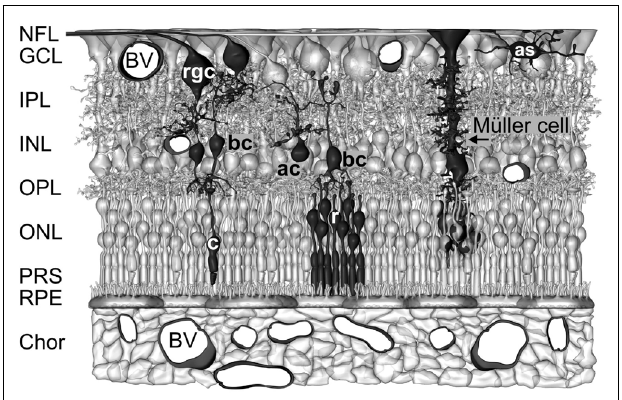
FIGURE 1 | Müller cells span the entire thickness of the neuroretina. Schematic drawing of the cellular constituents and basic neuronal circuits of a human retina.The inner retina contact the vitreal cavity ( top ) and contains the following retinal layers: nerve fiber layer (NFL), ganglion cell layer (GCL), inner plexiform layers (IPL), and inner nuclear layer (INL).The outer retina is directed to the outer surface of the eye and contains the following retinal layers: outer plexiform layer (OPL), outer nuclear layer (ONL), the subretinal space containing the photoreceptor segments (PRS), and the retinal pigment epithelium (RPE).The outer retina is supplied with oxygen and nutrients by the blood vessels (BV) in the choroid (Chor), while the inner retina is supplied by intraretinal vessels. Astrocytes (as) are localized in the NFL/GCL.The perikarya of Müller cells are localized in the INL. From the perikaryon, two stem processes of Müller cells extend toward both surfaces of the neuroretina.The funnel-shaped endfeet of Müller cells form (in association with a basement membrane) the inner surface of the retina. In the OPL and IPL, side branches which form perisynaptic membrane sheaths originate at the stem processes. In the ONL, the stem process of Müller cells forms membraneous sheaths which envelop the perikarya of rods (r) and cones (c). Microvilli of Müller cells extend into the subretinal space. ac, amacrine cell; bc, bipolar cell; rgc, retinal ganglion cell.